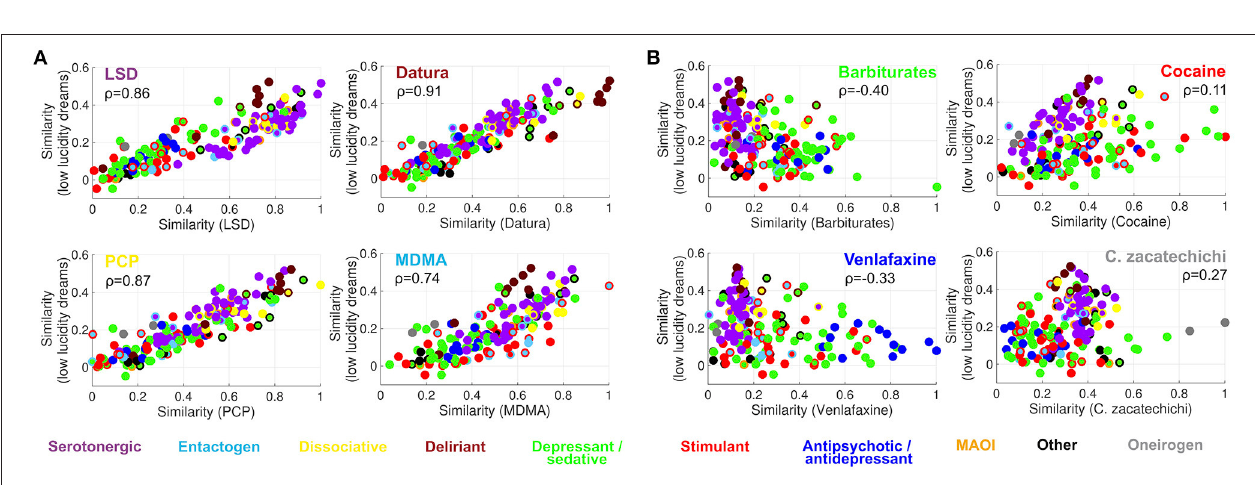
FIGURE 5 | Prediction of the similarity between the subjective report of substances and dreaming experiences of low lucidity, based on the similarity to LSD, plants of the Datura genus, PCP and MDMA (A) and to reports of barbiturates, cocaine, venlafaxine and Calea zacatechichi (B) . Substances are represented with circles that are color-coded as in Figure 1 . The inset shows the value of the Spearman’s rank correlation coefficient ( ρ